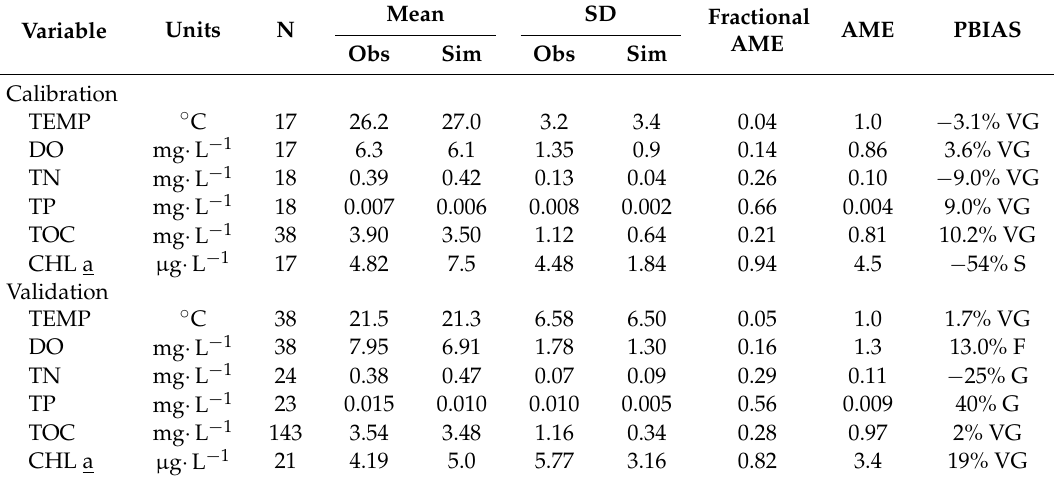
Table 3. Environmental Fluid Dynamics Code (EFDC) calibration (1 August 2001 to 31 December 2003) and validation (1 July 1996 to 31 December 1999) statistics at Converse Reservoir drinking water intake for temperature (TEMP), dissolved oxygen (DO), total nitrogen (TN), total phosphorus (TP), total organic carbon (TOC), and chlorophyll-a (CHL a). Unavailable performance ratings are based on temperature (for dissolved oxygen) and nutrient (for TOC and chlorophyll-a)